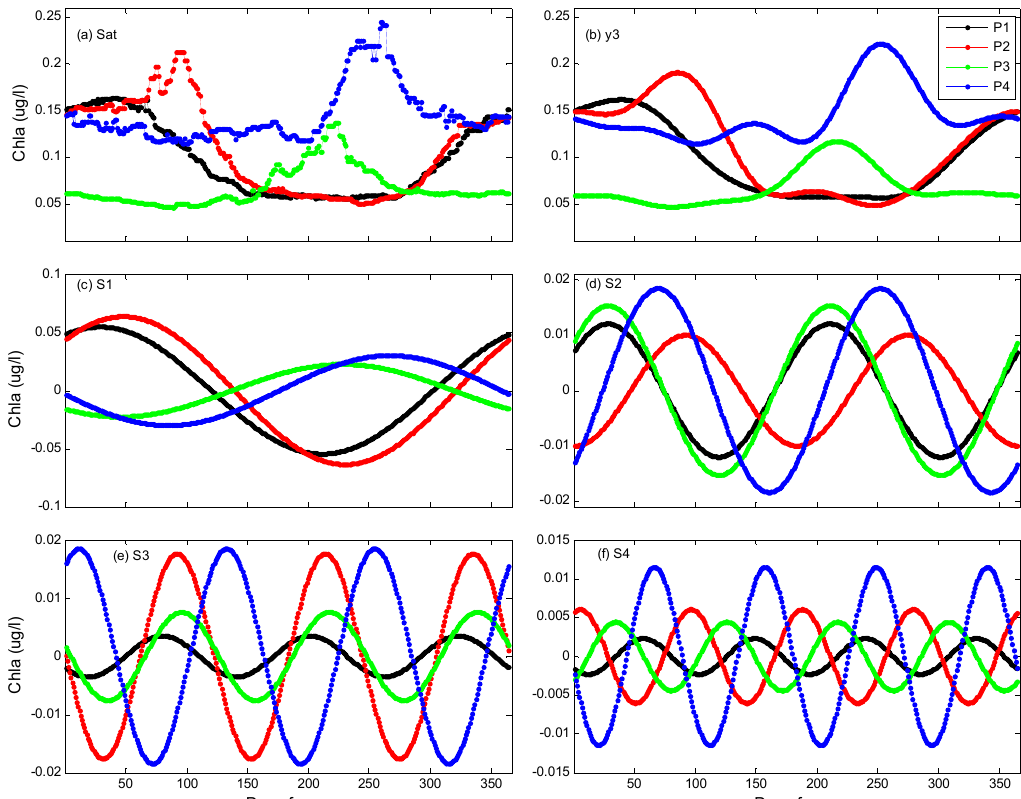
Figure 13. Comparisons of the daily climatology of satellite Chl-a ( a ) with the sinusoids of y3 ( b ), S1 ( c ), S2 ( d ), S3 ( e ), and S4 ( f ) among four sites of P1 (30.2 °N/77.4 °W) for Class 1, P2 (33.0 °N/68.0 °W) for Class 2, P3 (19.2 °N/59.4 °W) for Class 3, and P4 (6.2 °N/38.4 °W) for Class 4 with their locations marked in Figure 12b.